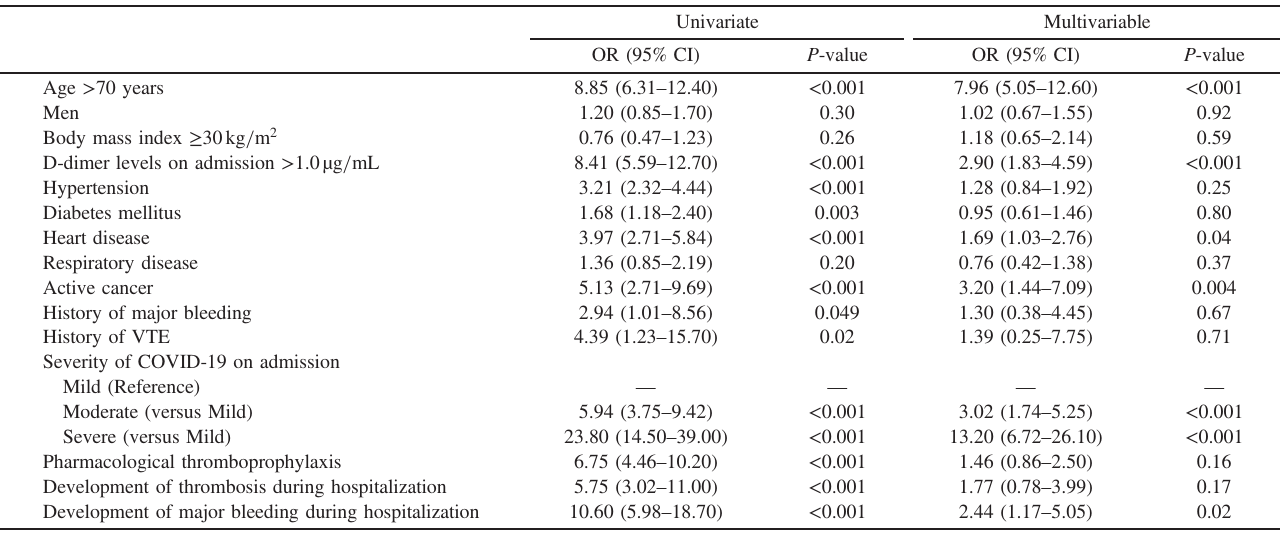
Table 3. Multivariable analysis for the risk factors for all-cause mortality during hospitalization